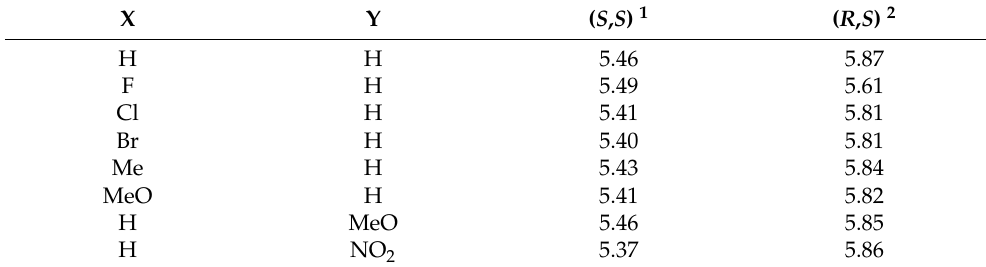
Figure 3. A prototypal X- and Y-substituted aminobenzylnaphthol. Table 1. H(1)-NMR chemical shift in ppm of the Ar 1 Ar 2 C-H benzyl hydrogen atom in the aminobenzylnaphthol of Figure 3, in which X and Y are the substituents on the respective aryl groups.